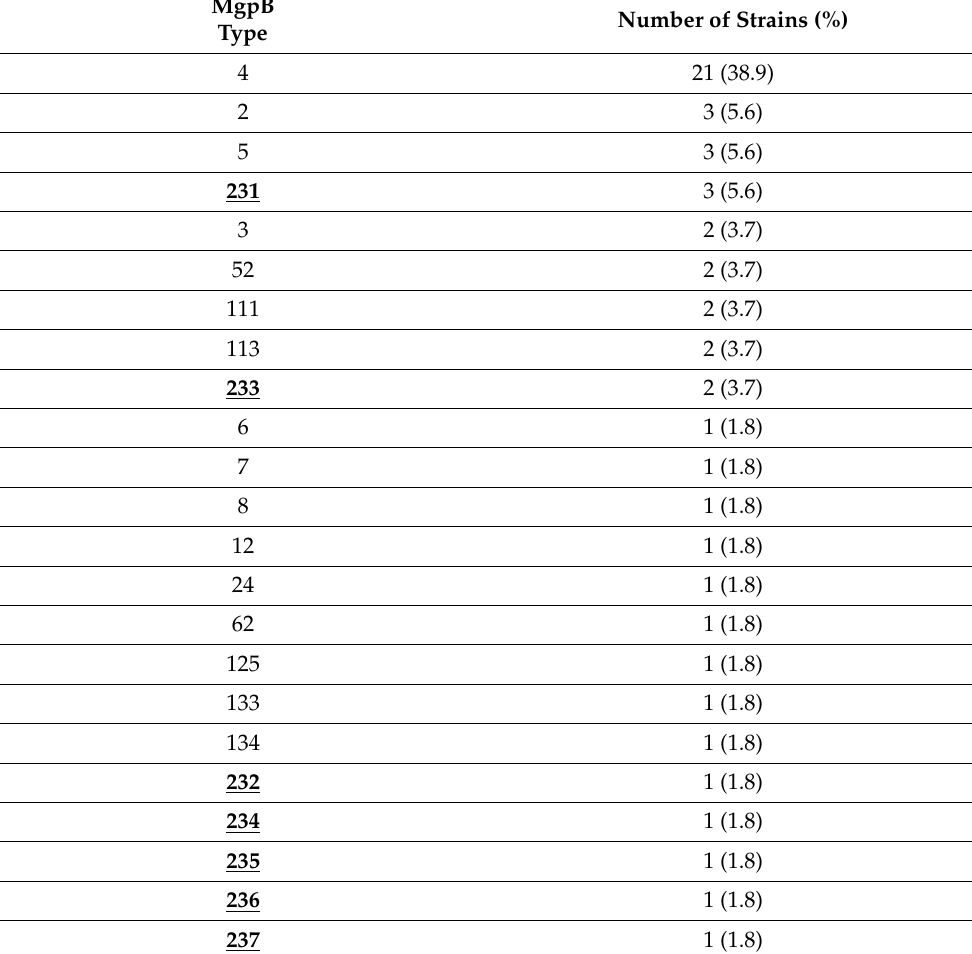
Table 2. Distribution of mgpB types of 54 M. genitalium clinical